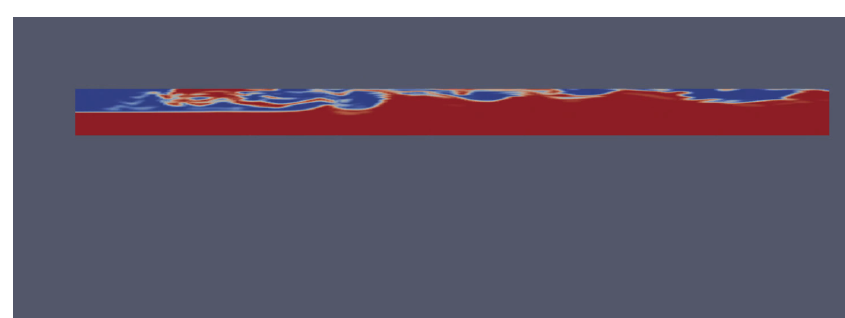
Figure 8. Plug flow pattern.